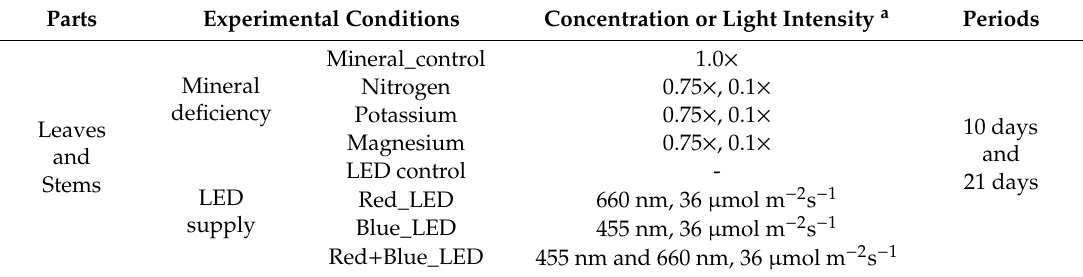
Table 1. Information about the experimental